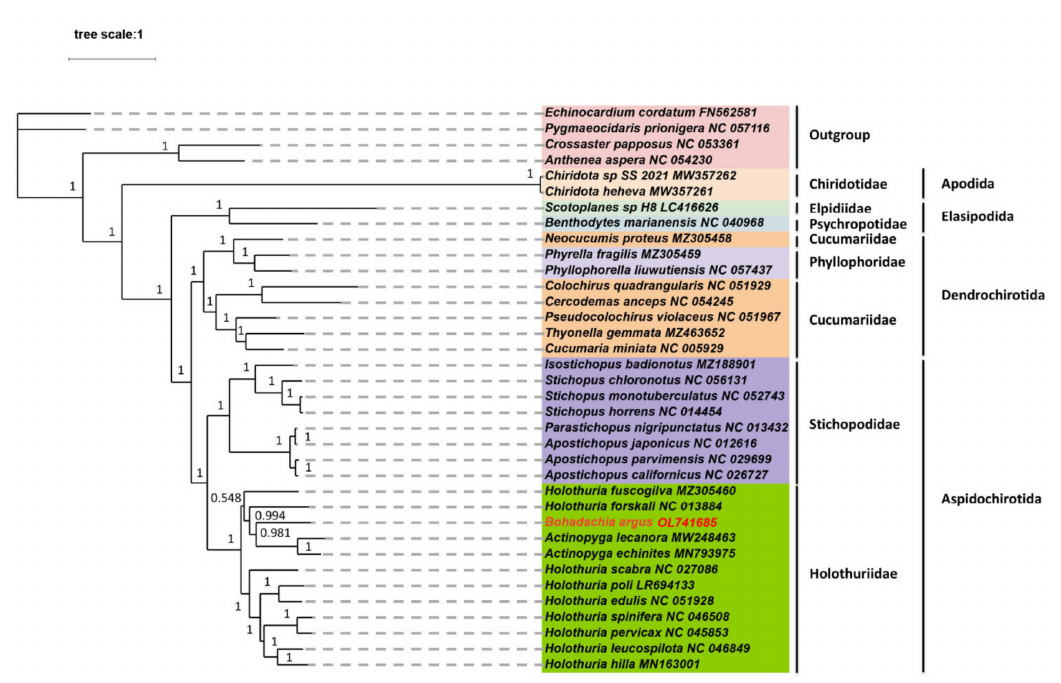
Figure 5. Phylogenetic tree derived from Bayesian inference (BI) of 13 mitochondrial PCGs in B. argus and other closely related species. Bayesian posterior probabilities are shown next to correspond- ing